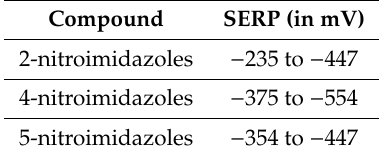
Table 1. Single electron reduction potentials (SERP) relative to the standard hydrogen electrode (extracted from [15]).